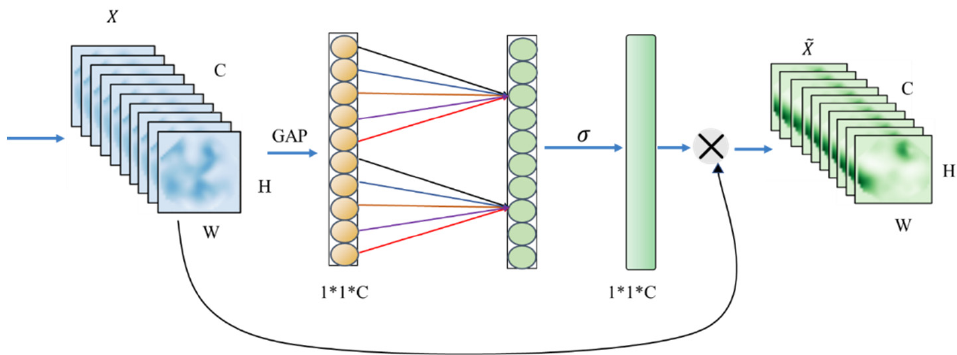
Figure 9. Structure of ECA.